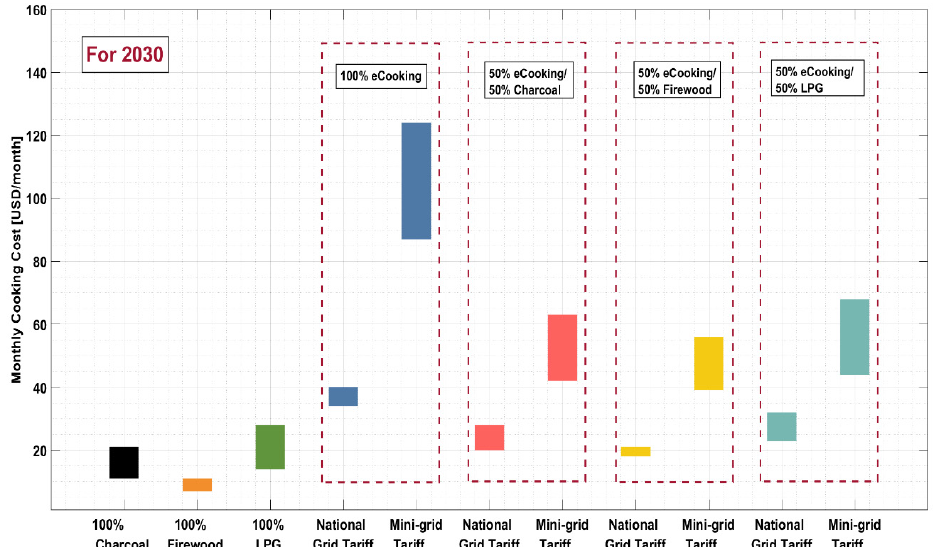
Figure 3. Monthly cooking cost of the contextualized cooking scenario under study calculated for 2030.